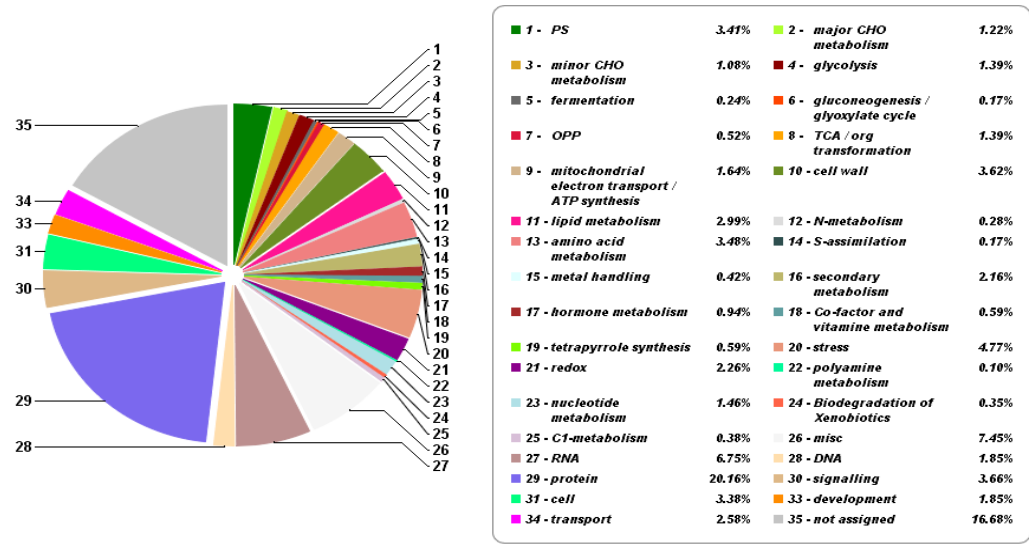
Figure 6. Protein classification of the sugar beet proteome GCs using Mercator